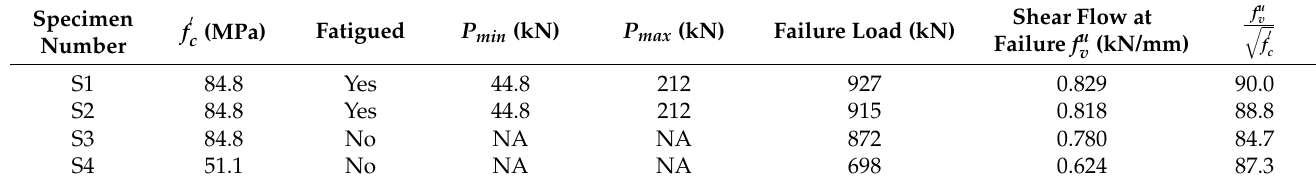
Table 2. Summary of A325 Connector Specimen Test Protocols and Strength Test Results.